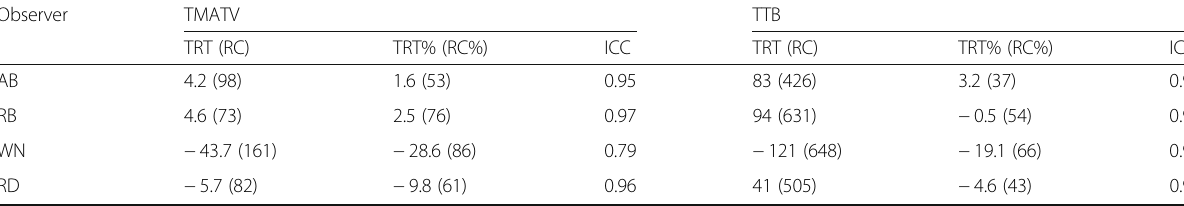
Table 3 Repeatability of experienced observers and reference delineation Observer TMATV